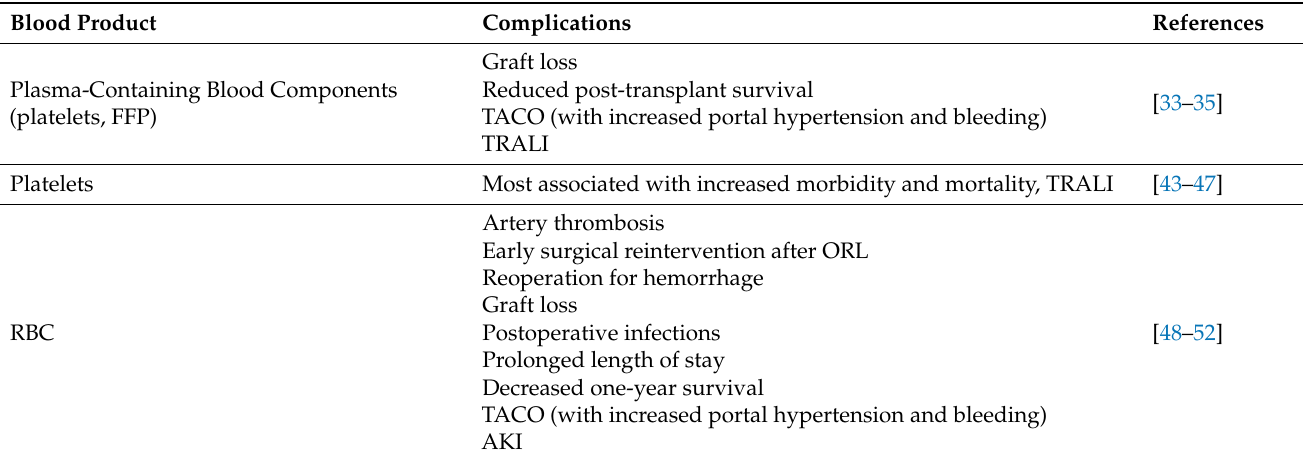
Table 1. Transfusion limitation in liver